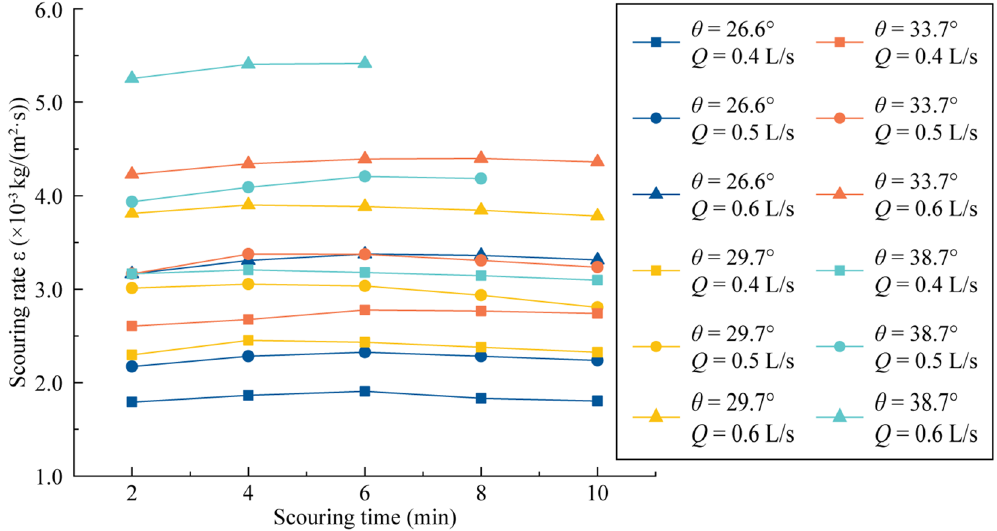
Figure 5. Variation in the erosion rate under different slope gradients and flow rates.